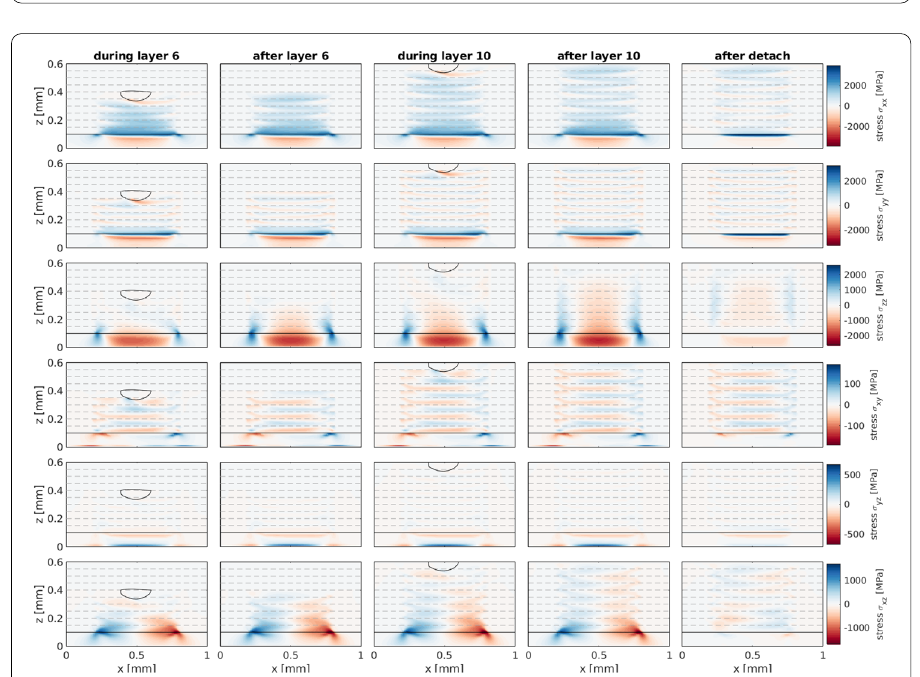
Fig. 16 Serpentine scanning pattern: distribution of different stress components in symmetry plane at selected time steps. Blue color represents tension, red color represents compression. Liquidus isotherm (solid black line) approximates melt pool